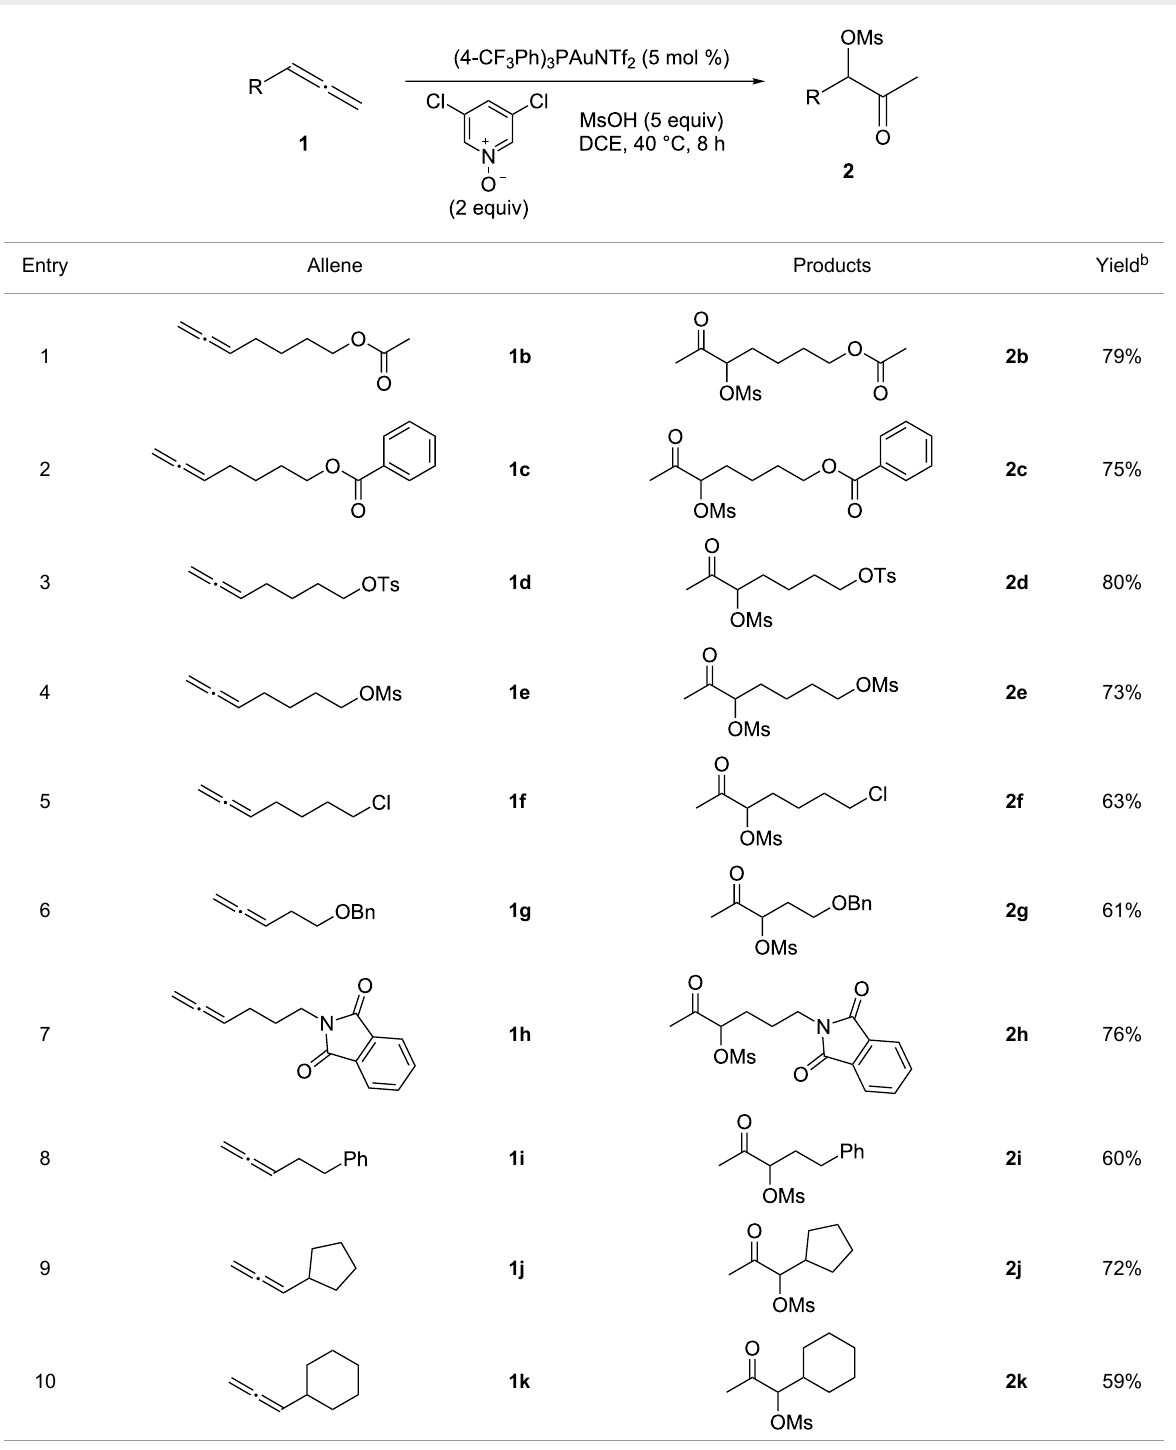
Table 2: Reaction scope a